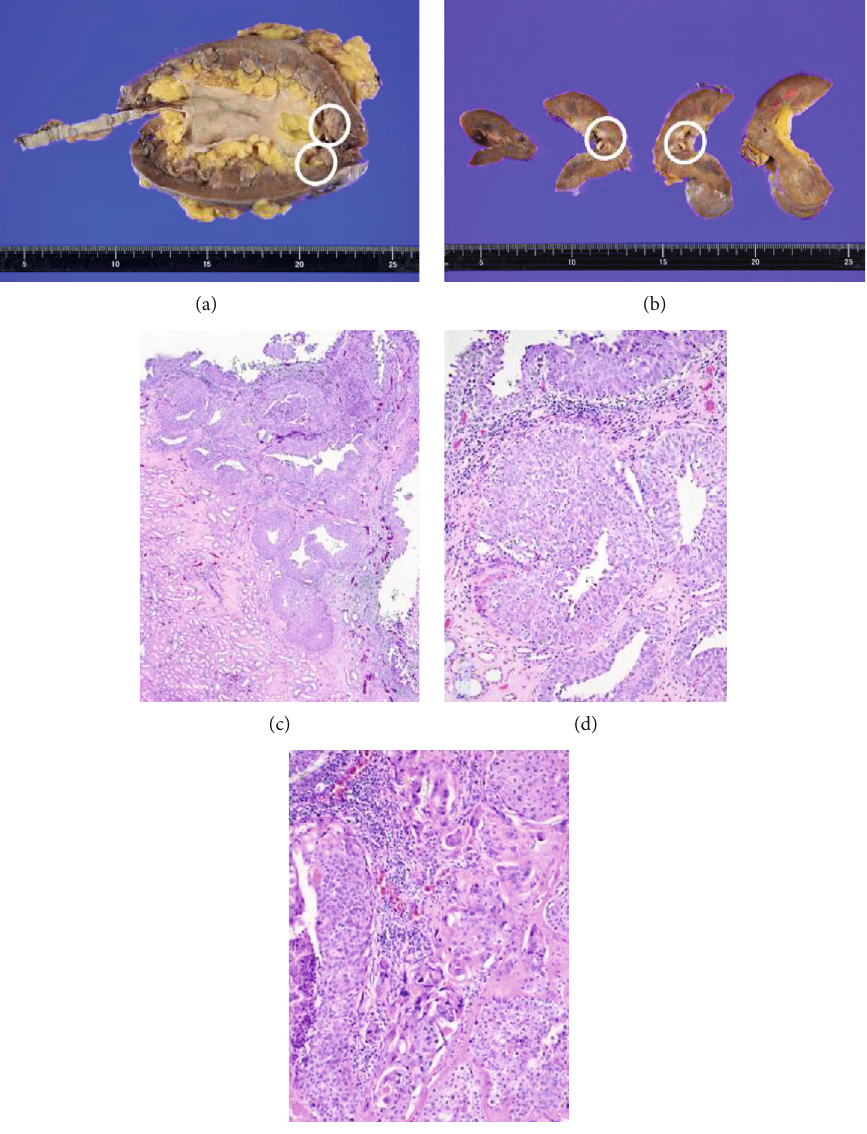
Figure 3: Pathological fi ndings. The macroscopic specimen reveals the tumor was a 30 × 15mm mass in the upper renal pelvis ((a, b), circle). The histopathological fi ndings of the renal pelvic tumor reveal invasive high grade urothelial carcinoma (c, d) with squamous di ff erentiation (e). The tumor invades renal papilla and there is no lymphovascular